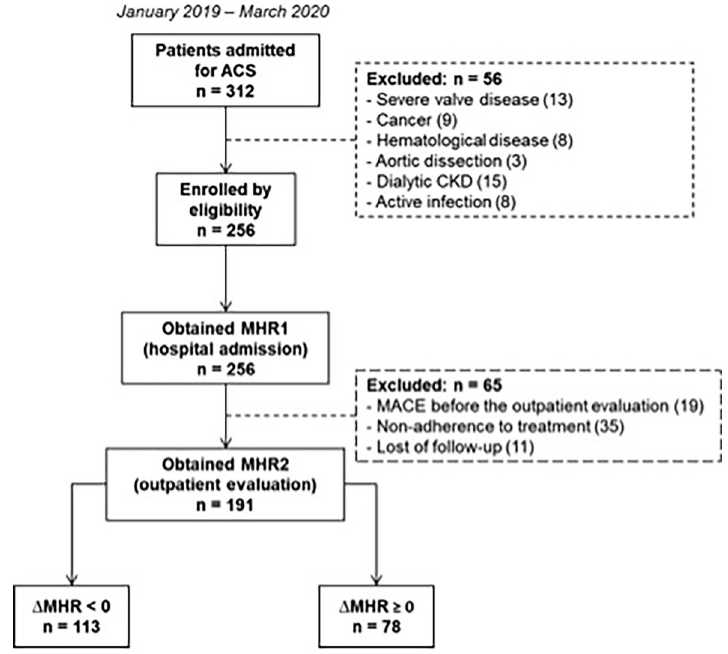
Figure 1. Flowchart of the patients included in this study. ACS: acute coronary syndrome; CKD: chronic kidney disease; MHR1: monocyte to high-density lipoprotein cholesterol ratio at hospital admission; MHR2: monocyte to high-density lipoprotein cholesterol ratio at fi rst outpatient evaluation; D MHR: MHR2 –